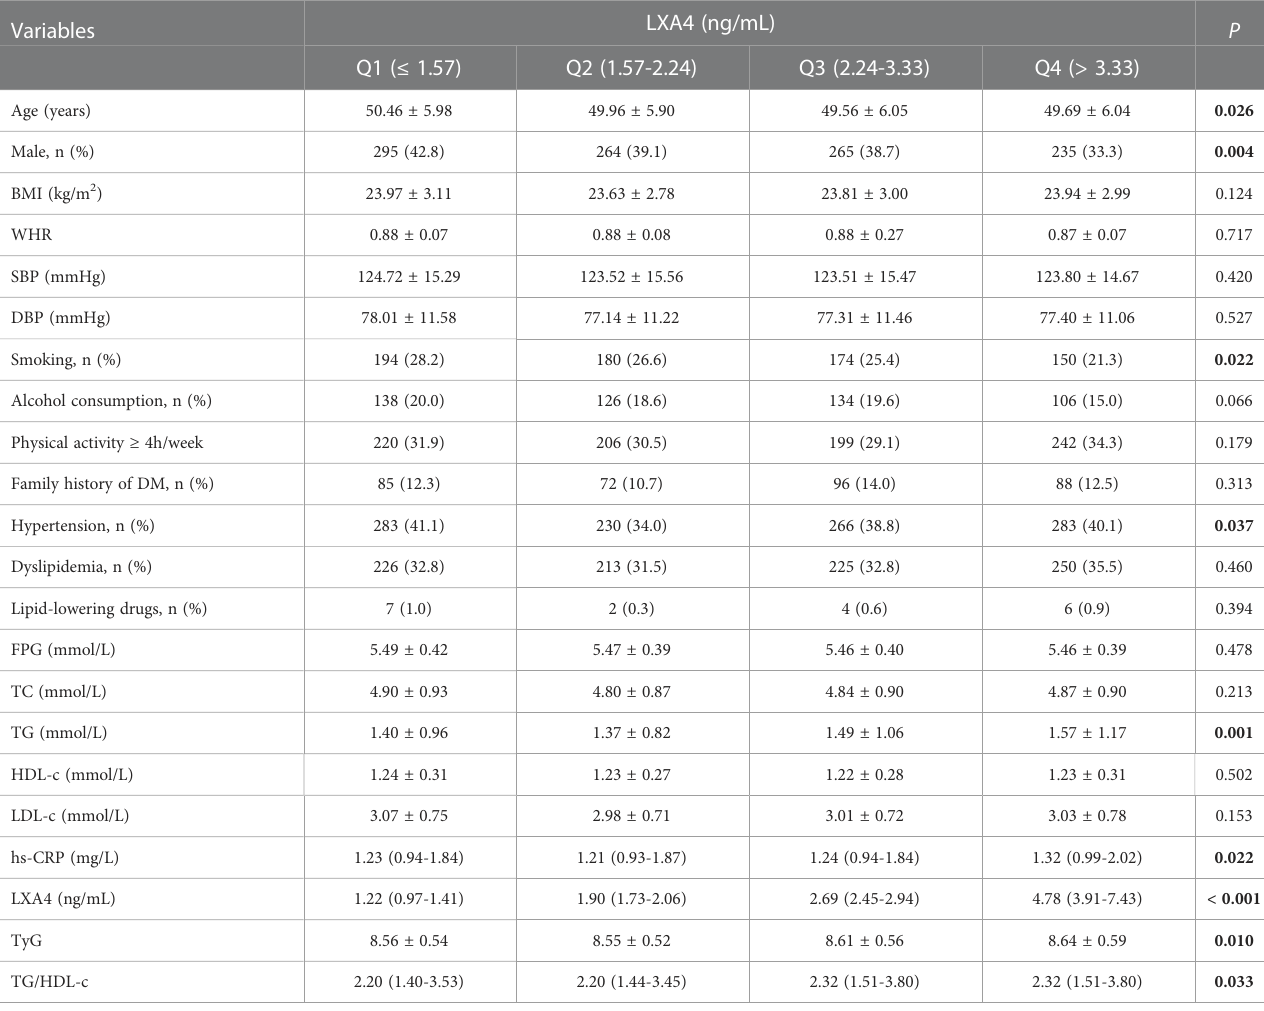
TABLE 1 Baseline characteristics of the study participant according to the quartiles of LXA4.